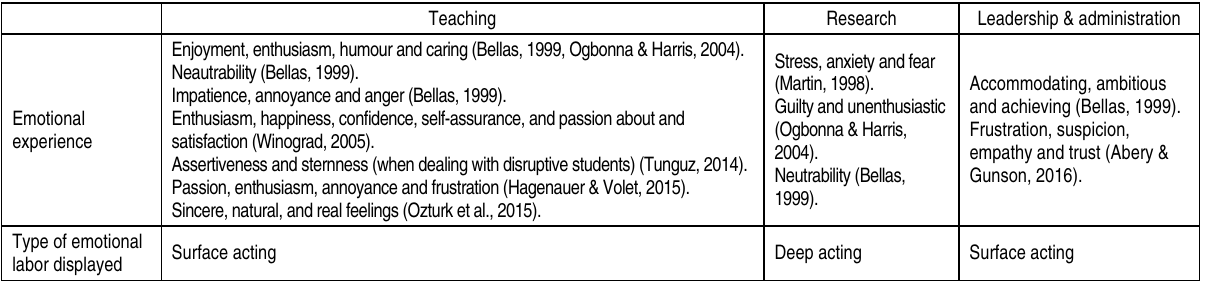
Table 1. Contextualization of emotions displayed by